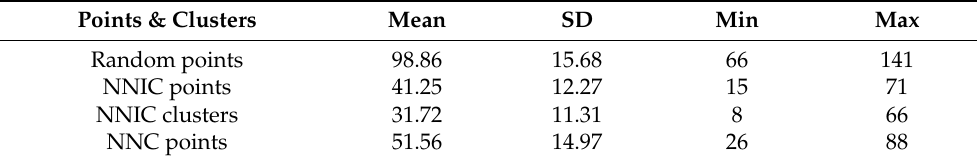
Table 2. Summary results for the real example. N points: number of points inside the study area; NNIC points: number of clustered points identified by NNIC; NNIC clusters: number of clusters identified by NNC; NNC points: number of clustered points identified by NNC; EX NND: expected nearest neighbour distance; Z statistic from the NNI and the corresponding p -value. NNIC: nearest neighbour index clustering. NNC: nearest neighbour cleaning. NNI: nearest neighbour